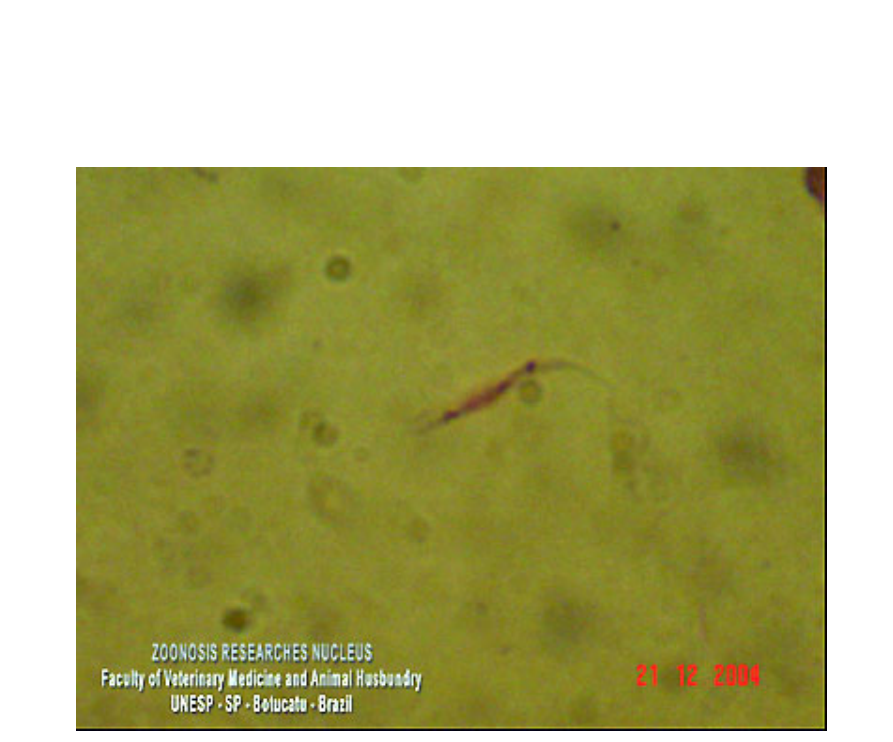
Figure 5: Smear of promastigote forms in LIT culture, isolated from the bone marrow puncture after 13 days of incubation at 28-30ºC, stained by the Giemsa method